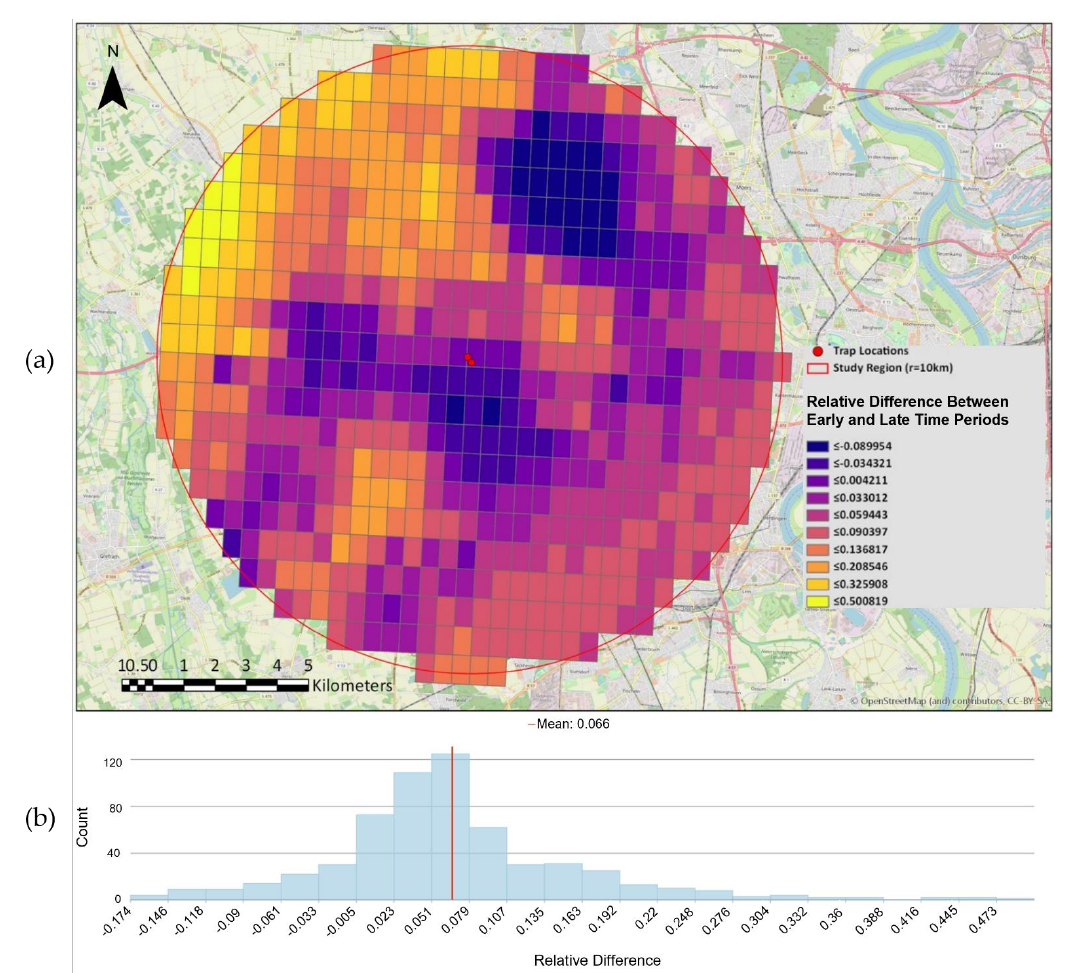
Figure 7. The spatial distribution of the relative difference in nightlight intensity for each pixel between the early time period (1992–1999) and late time period (2003–2010) derived through linear trend analysis ( a ). The distribution (frequency) of the relative difference in nightlight intensity for all pixels is shown below ( b ), where the mean relative difference (red line) was approximately a 7% increase in nightlight intensity.